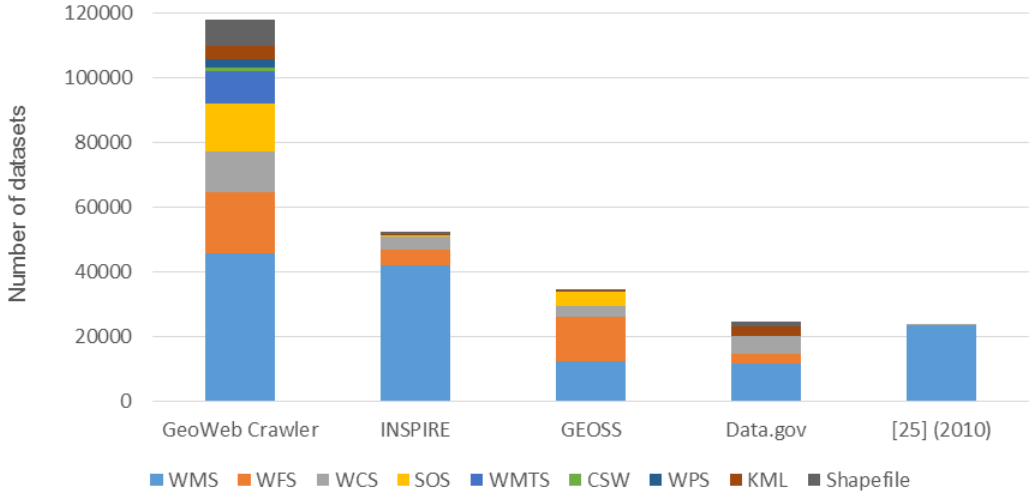
Figure 7. Number of datasets comparison between GeoWeb Crawler and existing approaches.